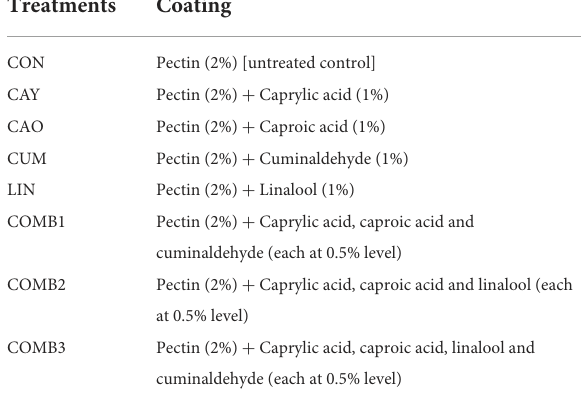
TABLE 1 Egg coating treatments used in this study.